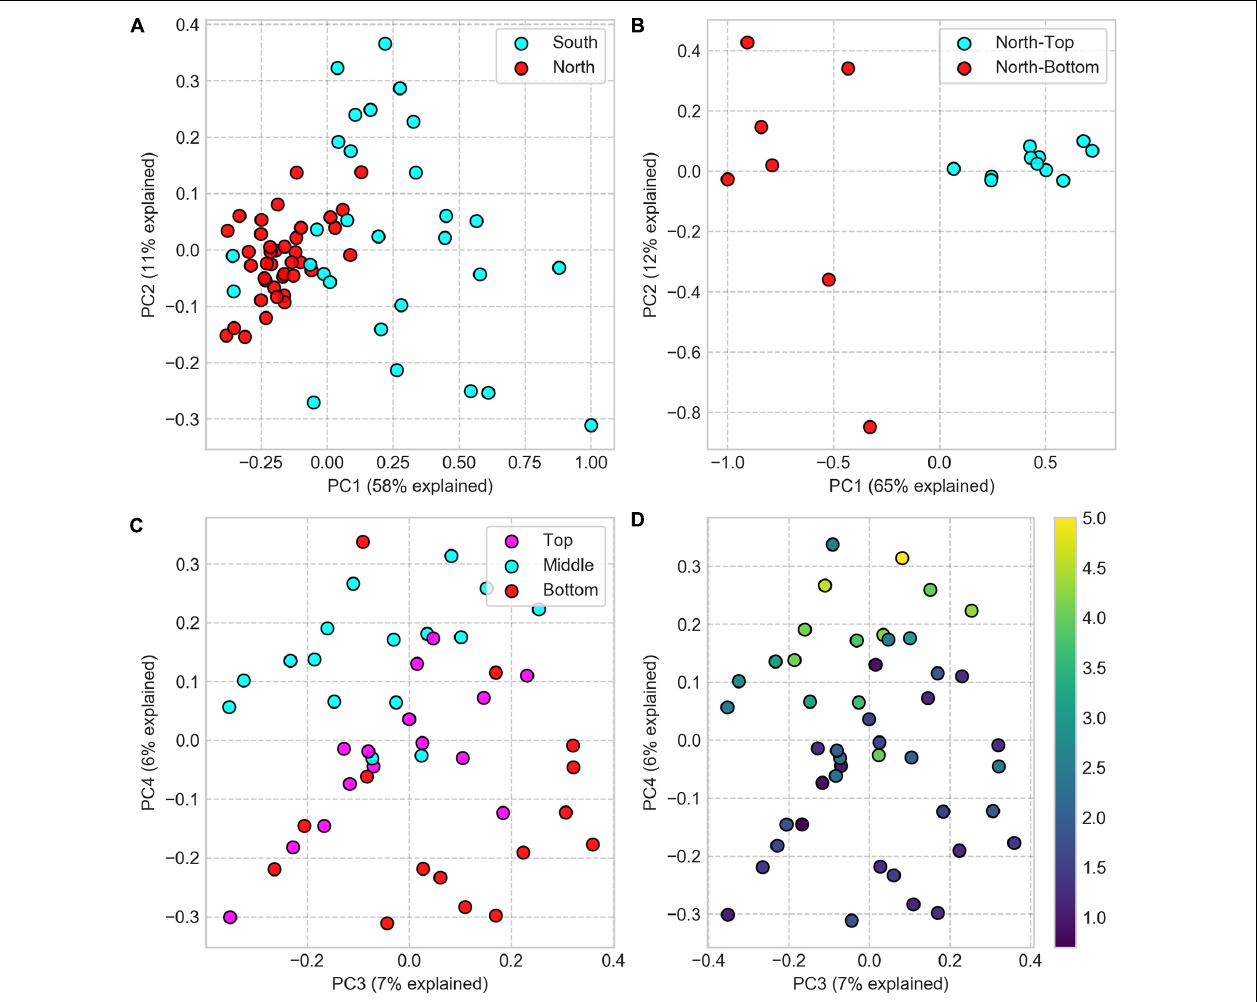
FIGURE 3 | PCoA of Weighted UniFrac dissimilarity matrix of 16S rRNA gene amplicon sequences, comparing community compositions in samples from different sampling locations. (A) Samples from North and South sites (difference is significant, PERMANOVA: p < 0.001, test statistic = 28.36). (B) Samples from North-top and North-bottom (difference is significant, PERMANOVA: p = 0.001, test statistic = 22.5). (C) Samples from the top, middle, and bottom positions within the halite nodules (note that the scatter plot projections show the third and fourth principal components). (D) Same as panel C but colored by the sample’s distance to the nodule’s surface (distance in cm encoded in